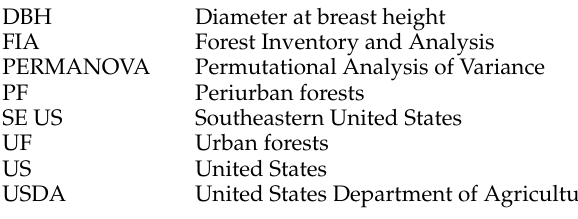
Table S1: Common species by location, Table S2: PERMANOVA results, Figure S1: Species accumulation curves by location, Figure S2: Origins of trees by